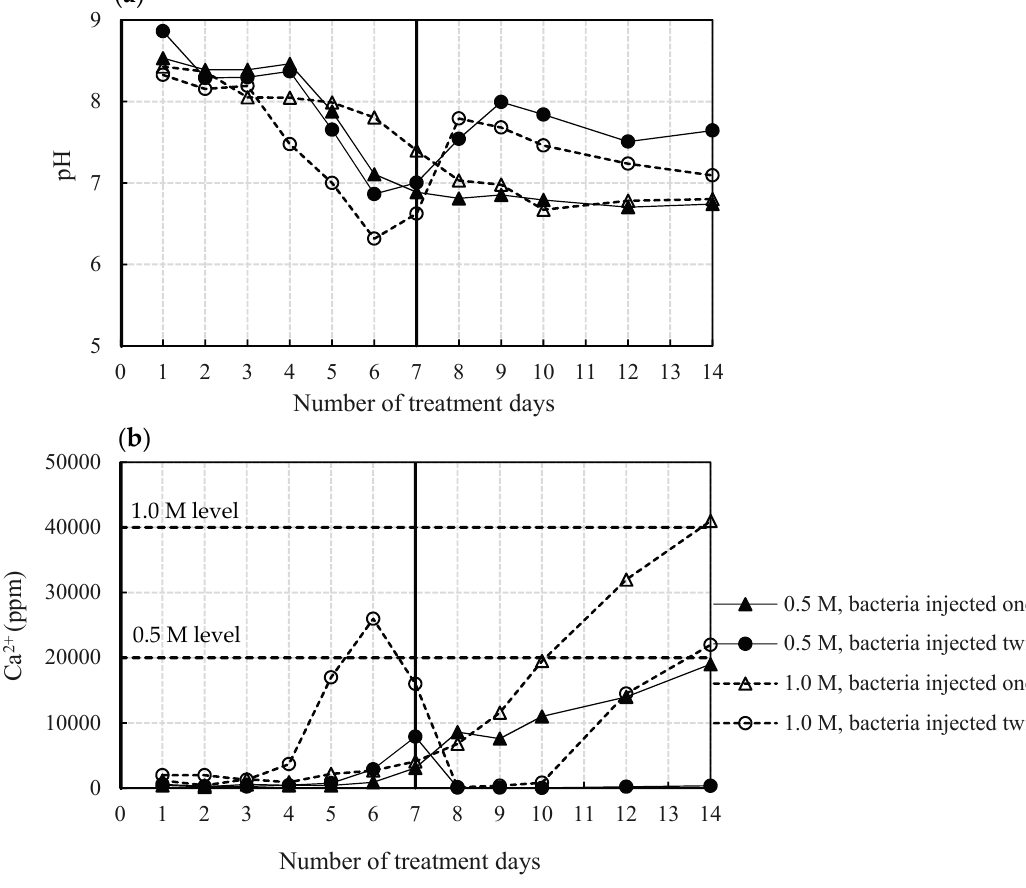
Figure 8. ( a ) pH; ( b ) Ca 2+ measurements of the solution collected from the bottom of the sand.